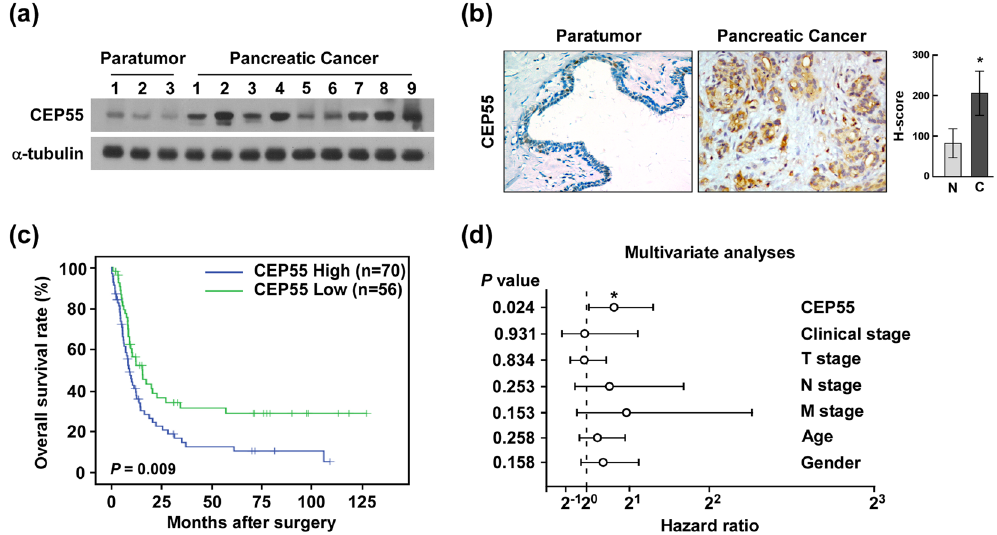
Figure 2. Overexpression of CEP55 protein correlated with poor prognosis in patients with pancreatic cancer (PANC). ( a ) Western blotting detection of CEP55 protein in three adjacent normal pancreas tissues and nine pancreatic cancer tissues. ( b ) Immunochemical analysis of CEP55 protein expression in 126 pancreatic cancer specimens (left panel), magnification × 400. Statistical quantification of the H-score of CEP55 staining of 126 pancreatic cancer specimens (right panel). ( c ) Kaplan-Meier survival curves for 126 pancreatic cancer patients with high CEP55-expressing versus low CEP55-expressing tumours. ( d ) Multivariate analyses between CEP55 protein expression and clinicopathological characteristics of 126 pancreatic cancer specimens. * P < 0.05, ** P <